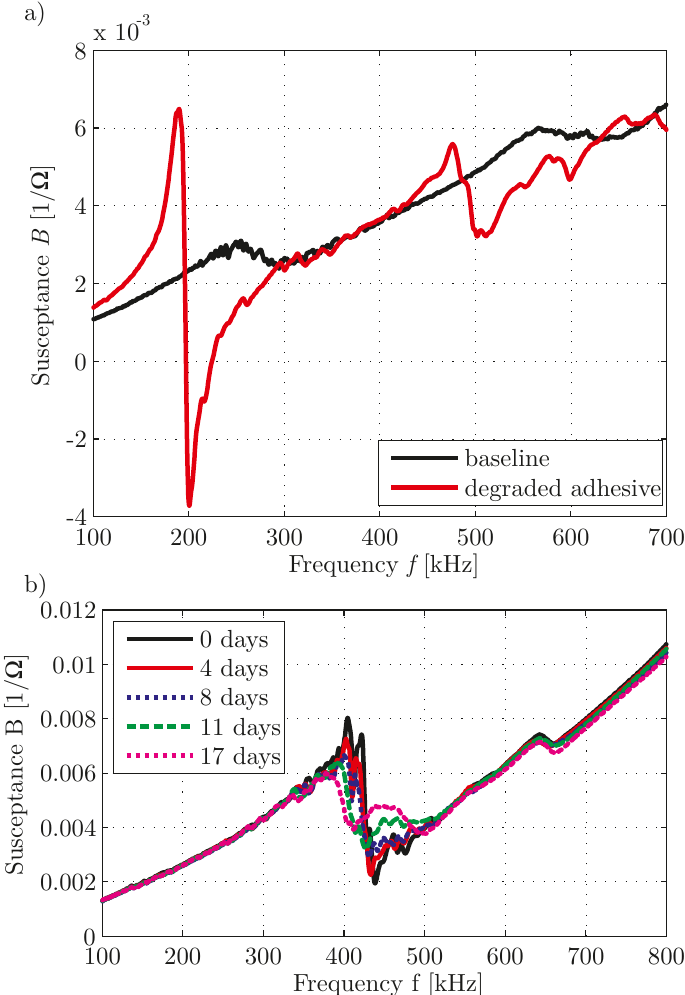
Figure 9. Susceptance spectra for PWAS with degradation caused by treatment with dimethylformamide: ( a ) Simple disc-shaped transducer, PIC 255, diameter 10 mm, thickness 0.5 mm, bonded to an aluminum plate; ( b ) embedded transducer, material of PIC 255, type DuraAct, see [34], cobonded to a CFRP strip, duration of treatment in days is given as a